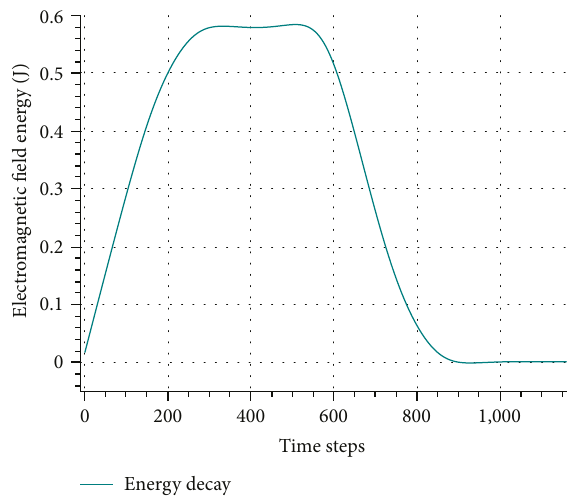
Figure 7: Electric fi eld behaviour in the viewers of interest, for free propagation experiment. The di ff erence in the values of the fi eld for the CPML and the reference solutions is negligible. When the source is turned o ff , the fi eld is accurately absorbed by the CPML